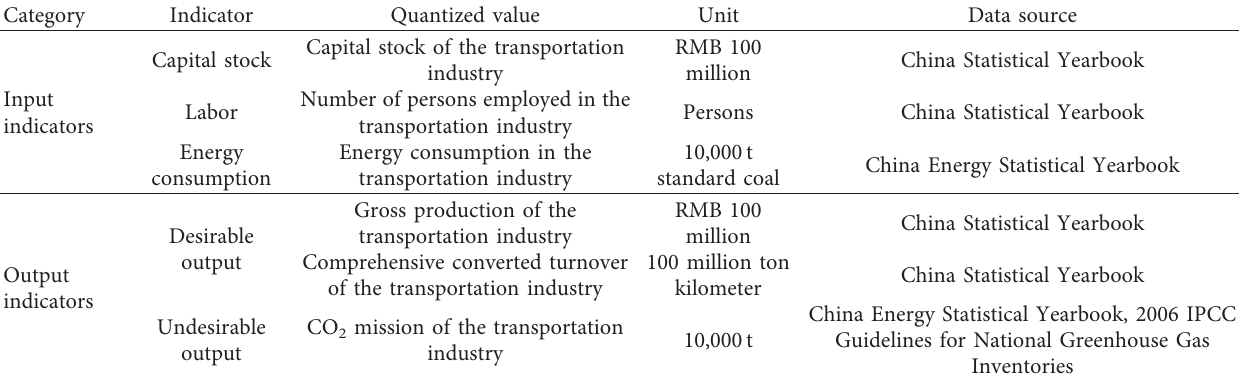
Table 1: Indicators used to assess unified economic and environmental efficiency of transportation infrastructure.